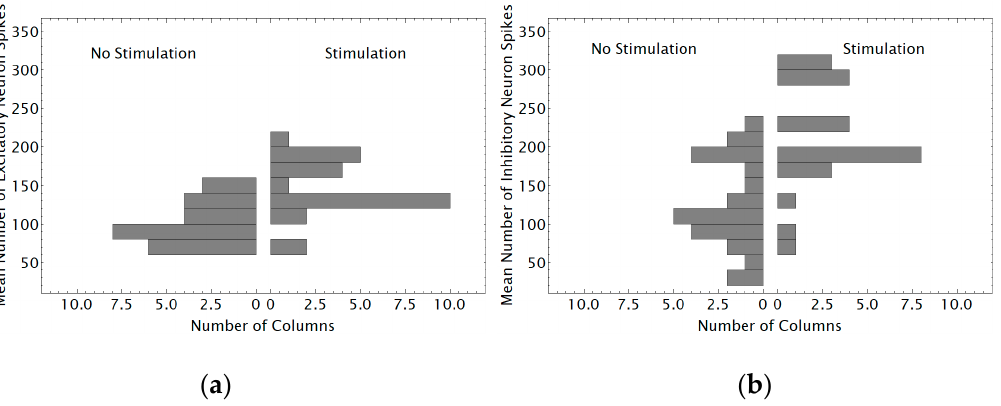
Figure 5. The distributions of numbers of spikes for network excitatory ( a ) and inhibitory ( b ) neurons in columns 1–25 averaged over 10 s simulations are shown for both no stimulation and stimulation conditions. The frequency of extrinsic excitatory action potentials was set to 70/s .